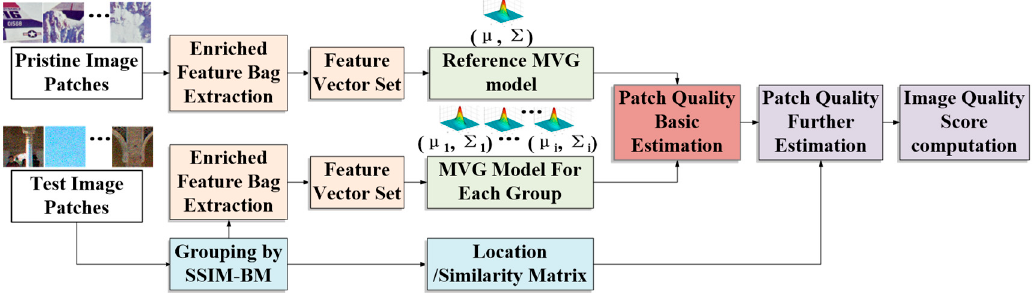
Figure 2. A general framework of the proposed BM-IQE model.